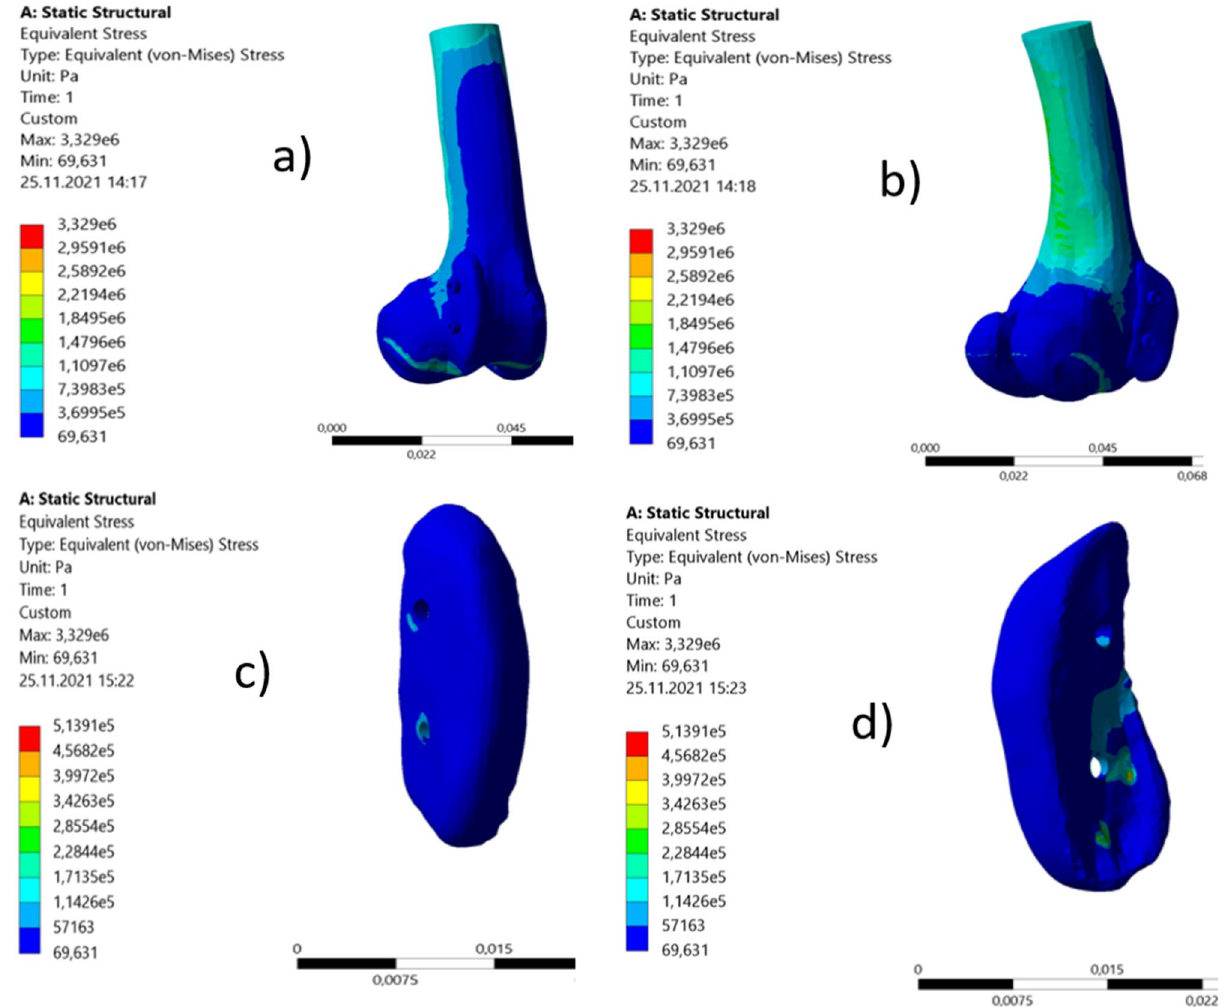
Figure 7. The stress distributions on the bone model and implant. Front view ( a ) and backside ( b ) of the bone model, outer surface of the implant ( c ) and inner surface of the implant ( d ).